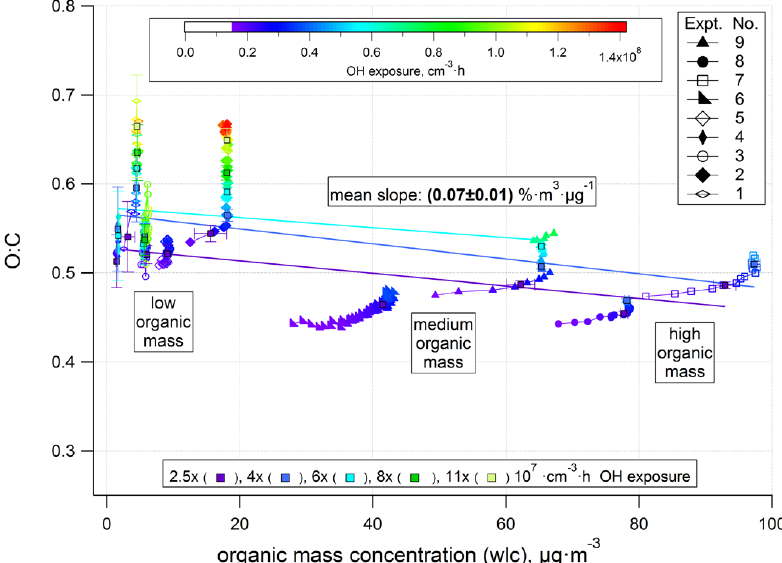
Fig. 3. O:C ratio as a function of the organic mass concentration (µgm − 3 ) in the chamber for the nine experiments. The color code indicates the OH exposure. Thirty-minute mean values at selected OH exposures are represented by colored squares (except expt. 4: 60-min average). The colored lines represent linear least orthogonal distance fits between O:C and org (wlc) at three selected OH exposures with a mean slope of (0 . 07 ± 0 . 01)%m 3 µg − 1 .